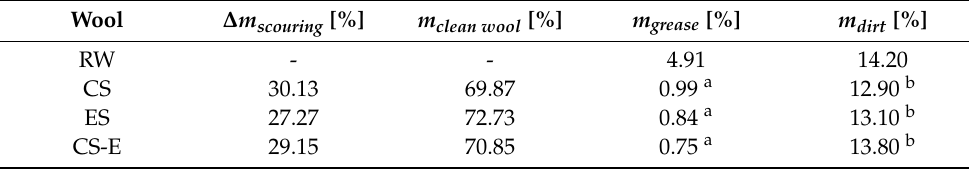
Table 1. The loss of raw wool mass in scouring ( ∆ m scouring ), and absolutely dry clean wool ( m clean wool ), extracted grease ( m grease ) and dirt ( m dirt ) present in wool.